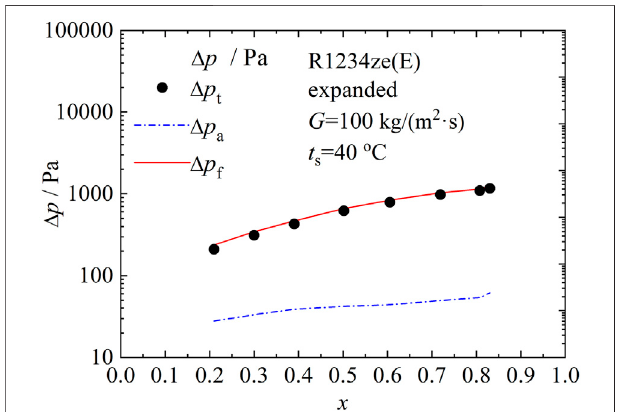
FIGURE 7 | Pressure drop components in the expanded micro- fi n